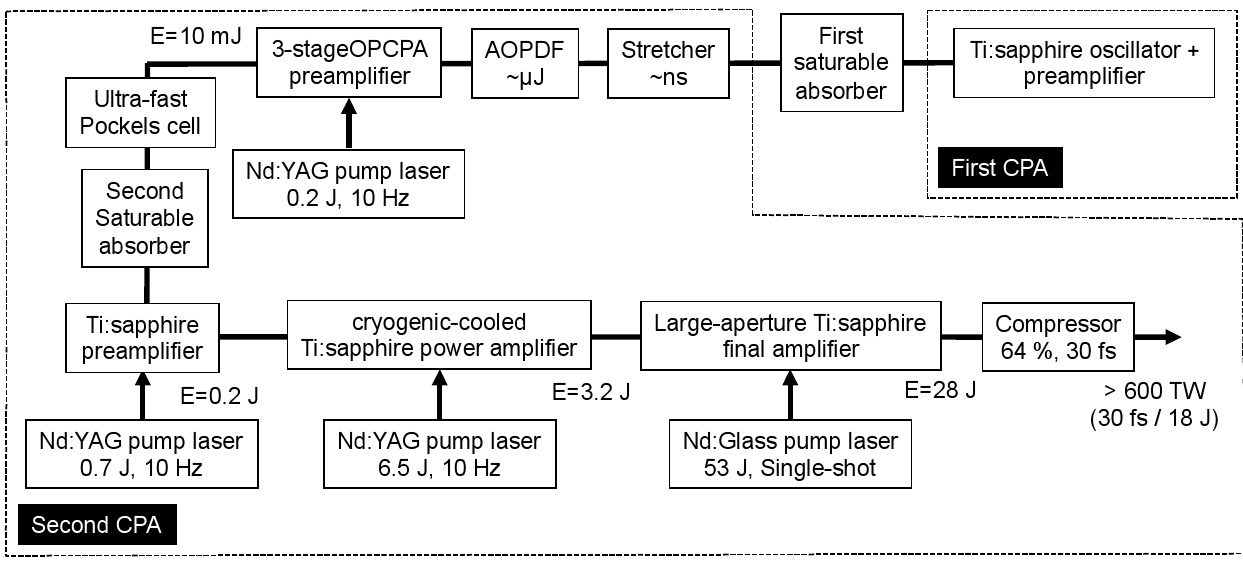
Figure 1. Schematics of the J-KAREN laser